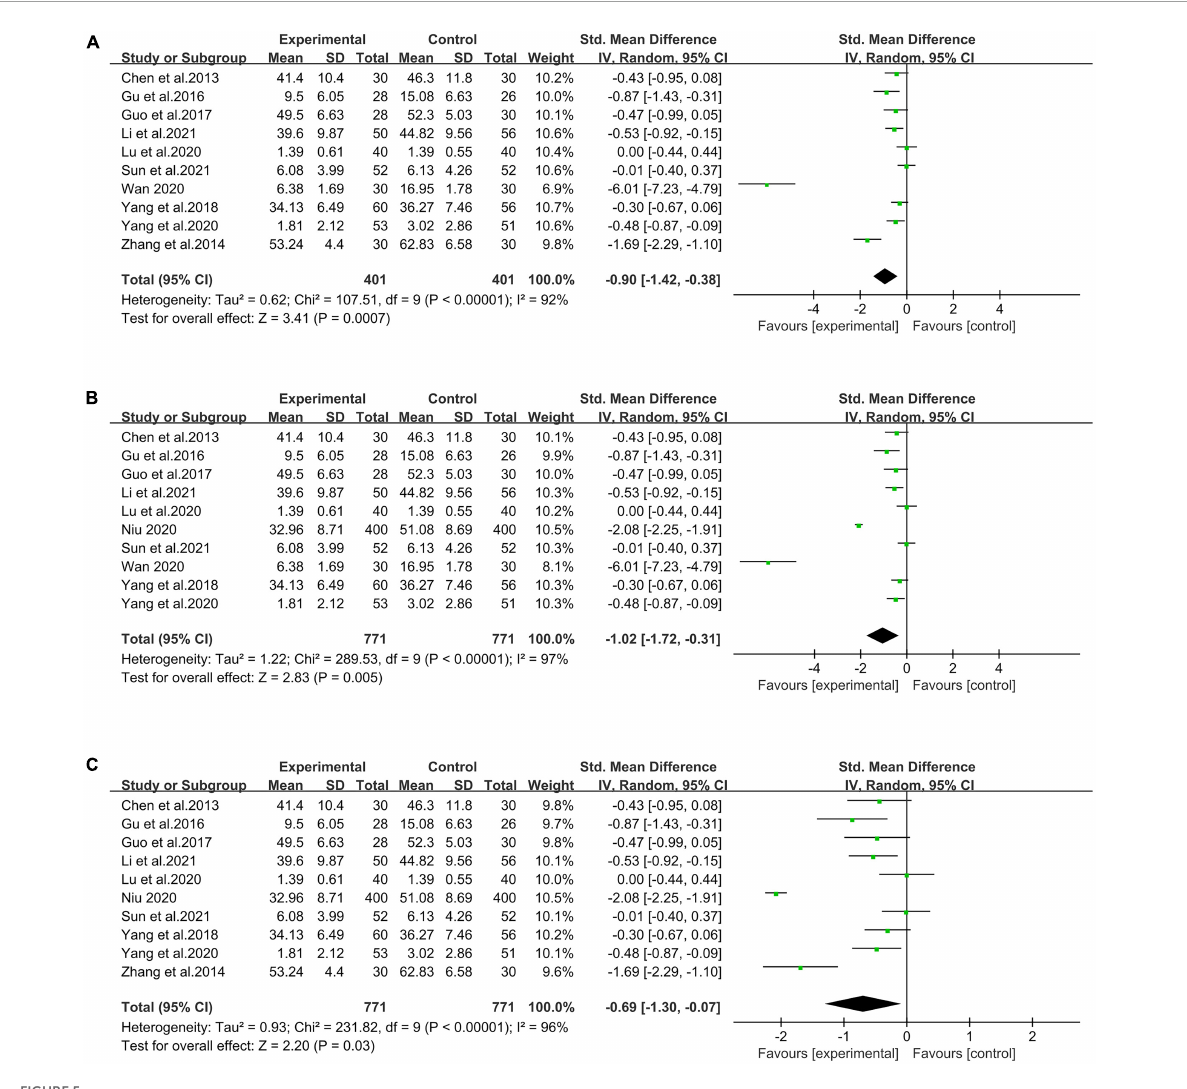
FIGURE5 Forest plot of effects of sensitivity analysis. (A) Sensitivity analysis without Niu (2020); (B) sensitivity analysis without Zhang and Zhu (2014); (C) sensitivity analysis without Wan